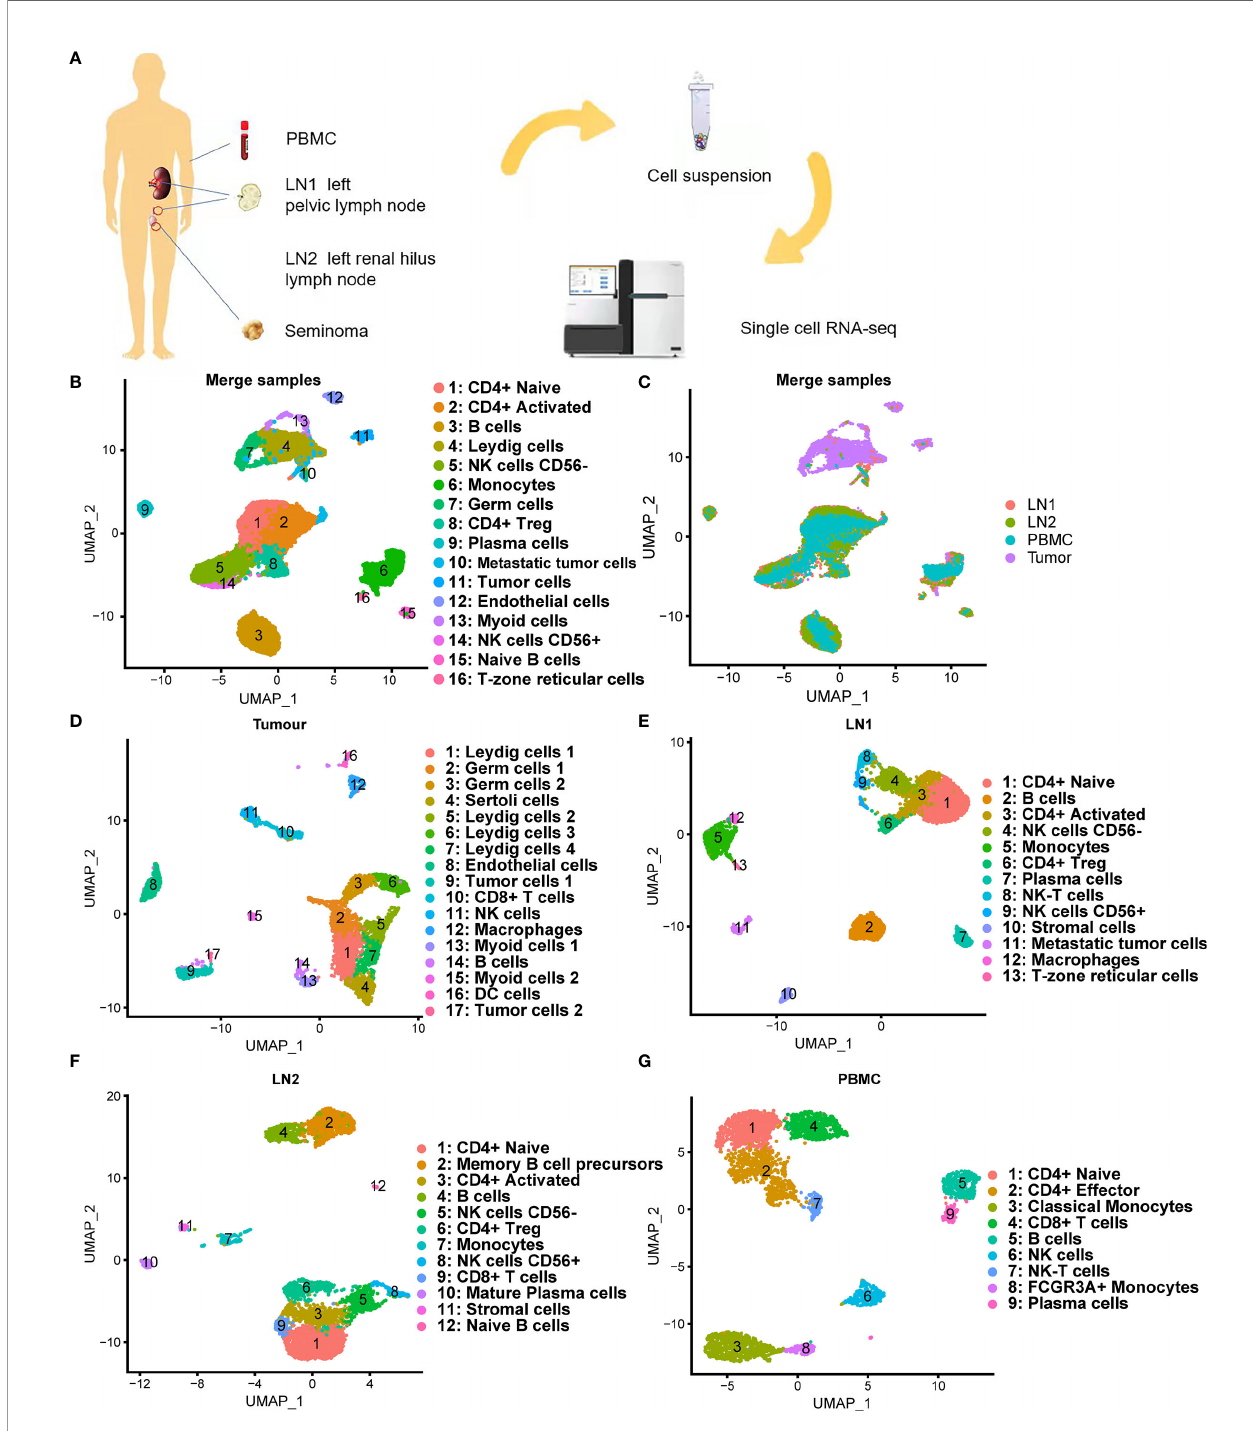
FIGURE 2 | Single-cell transcriptomic atlas of testicular seminoma sample. (A) Schematic design of the overall design. (B, C) Single-cell transcriptomic map of testicular tumor (Tumor), left pelvic lymph node (LN1), left renal hilus lymph node (LN2) and peripheral blood mononuclear cells (PBMC), with 16 distinct cell types. (D) UMAP plot representation of testicular seminoma (Tumor) with 17 distinct cell types. (E) UMAP plot representation of left pelvic lymph node (LN1) with 13 distinct cell types. (F) UMAP plot representation of left renal hilus lymph node (LN2) with 12 distinct cell types. (G) UMAP plot representation of PBMCs with 9 distinct cell